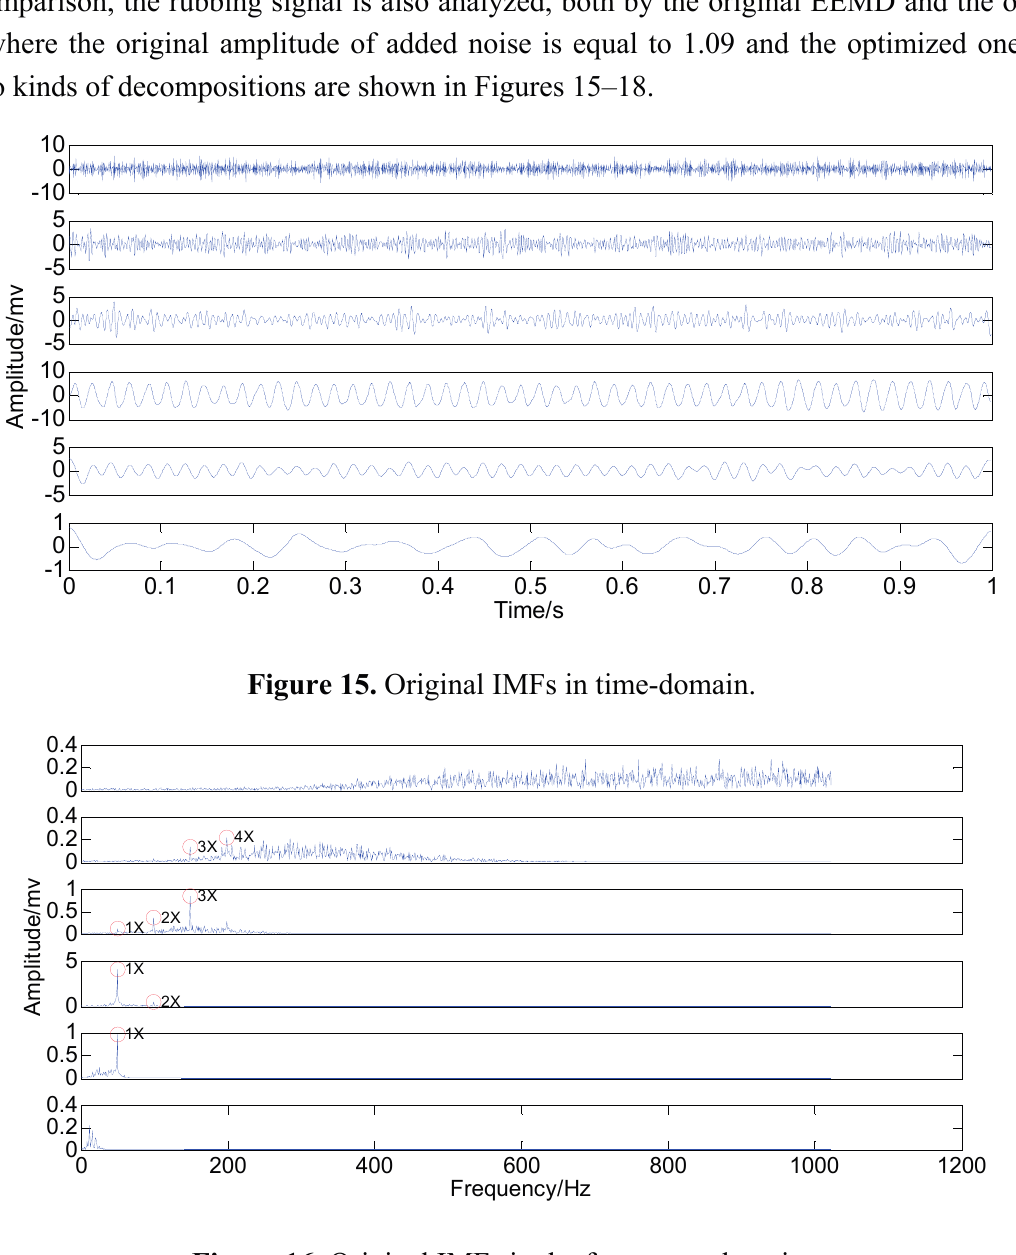
Figure 16. Original IMFs in the